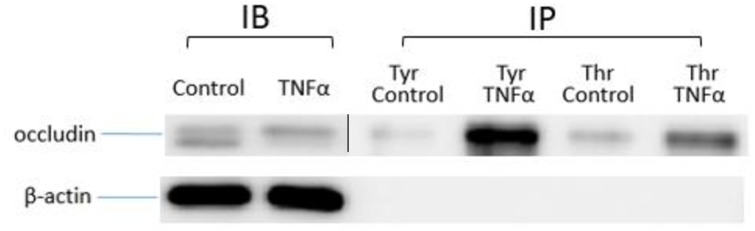
Effects of TNFα on tyrosine and threonine phosphorylation of occludin.hCMEC/D3 cells were treated with or without 10 ng/mL TNFα for 15 min. Cell lysates were mixed with anti-tyrosine or anti-threonine antibody conjugated with protein A beads and then phosphorylated proteins in cell lysates were pulled down. Occludin and β-actin expression pattern was analyzed by immunoblotting assay.